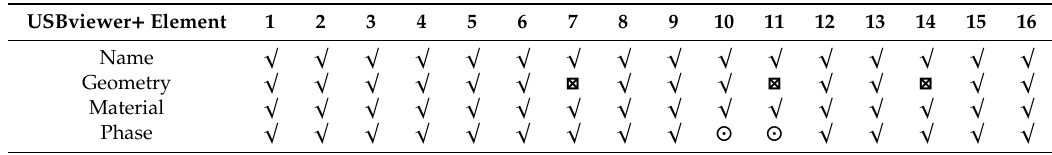
Table 4. Results of tests of BIM interoperability through the IFC standard, obtained by importing